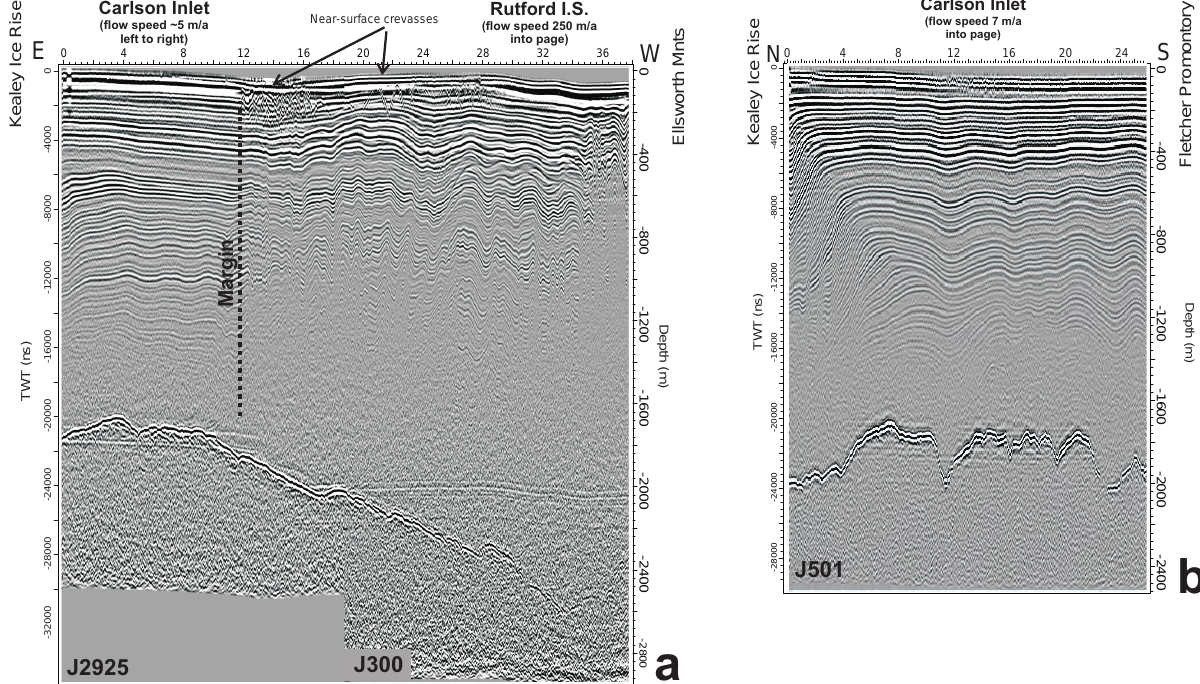
Fig. 2. Topographically-corrected radargrams across Rutford Ice Stream and the upstream part of Carlson Inlet. Locations in Fig. 1, horizontal scales are in kilometres, depth scales are based on a uniform radar wave speed of 0.168mns − 1 . Horizontal banding is a processing artefact. (a) Profile crossing the shear margin between Rutford Ice Stream and Carlson Inlet, flow direction is into the page for Rutford Ice Stream but is left to right for the Carlson Inlet section. Wavelength and amplitude of folding of isochrones changes beneath the outer edge of a band of near-surface crevasses that marks the shear margin. Folding in Rutford Ice Stream is very similar to the “fast-flow signature” described from Kamb Ice Stream by Ng and Conway (2004), here interpreted as the signature of convergent flow within the broad catchment upstream. (b) Profile crossing Carlson Inlet between Fletcher Promontory and Kealey Ice Rise, flow direction is into the page. Isochrone folds have long wavelengths, small amplitudes and conform to the basal topography except for a narrow zone within 3km of the margin with Kealey Ice